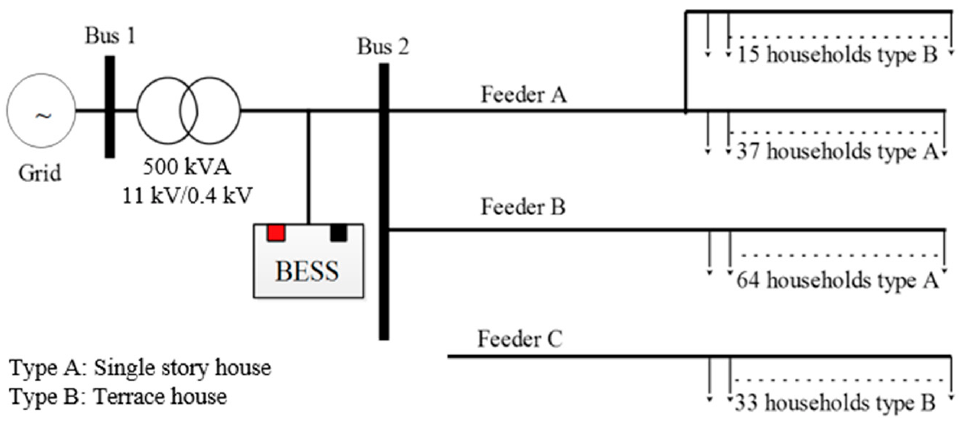
Table 2. Feeder loading condition.